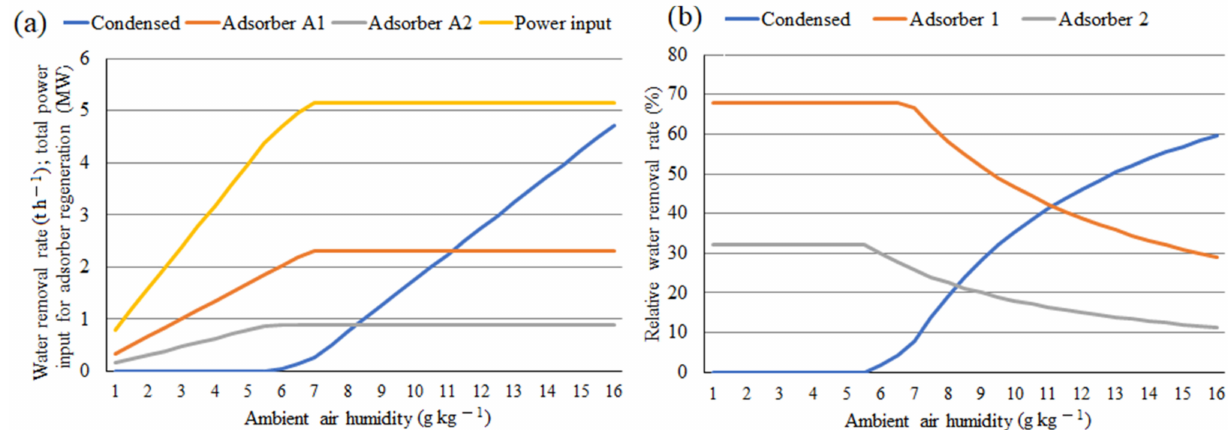
Figure 7. ( a , b ) Water removal rate and total power input for adsorber regeneration ( a ) and water removal rate distribution ( b ) as a function of ambient air humidity for model without absorption coolers. Condensed = water condensed in compression section intercoolers and coolers; Adsorber A1 = water removed in adsorber A1; Adsorber A2 = water removed in adsorber A2.